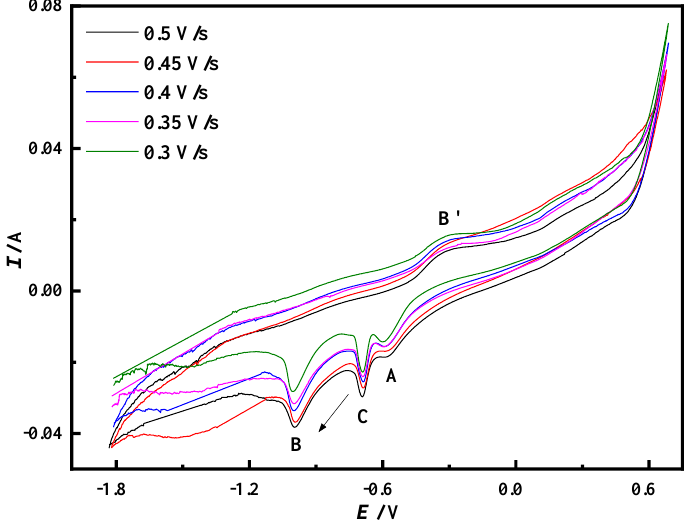
Figure 2. Cyclic voltammogram on Mo electrode in NaCl-CaCl 2 -LiNiO 2 system (Scan speed: 0.3–0.5 V/s, T = 750 °C, reference electrode: Pt electrode).